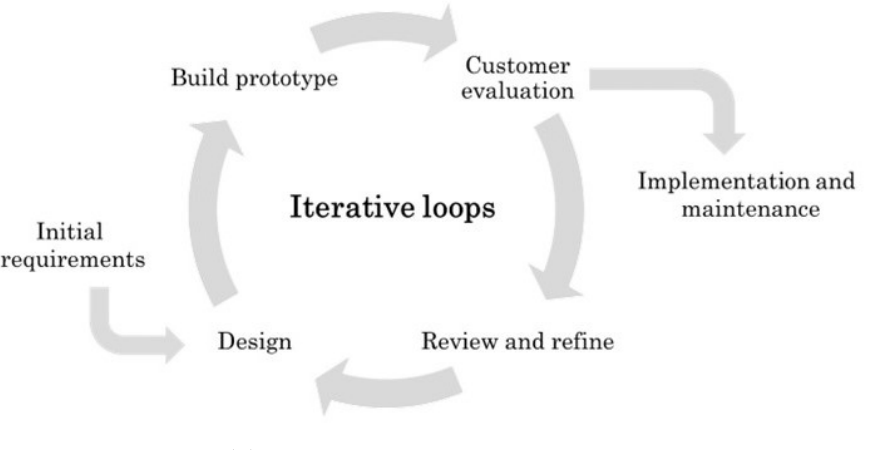
Figure 4. Prototype